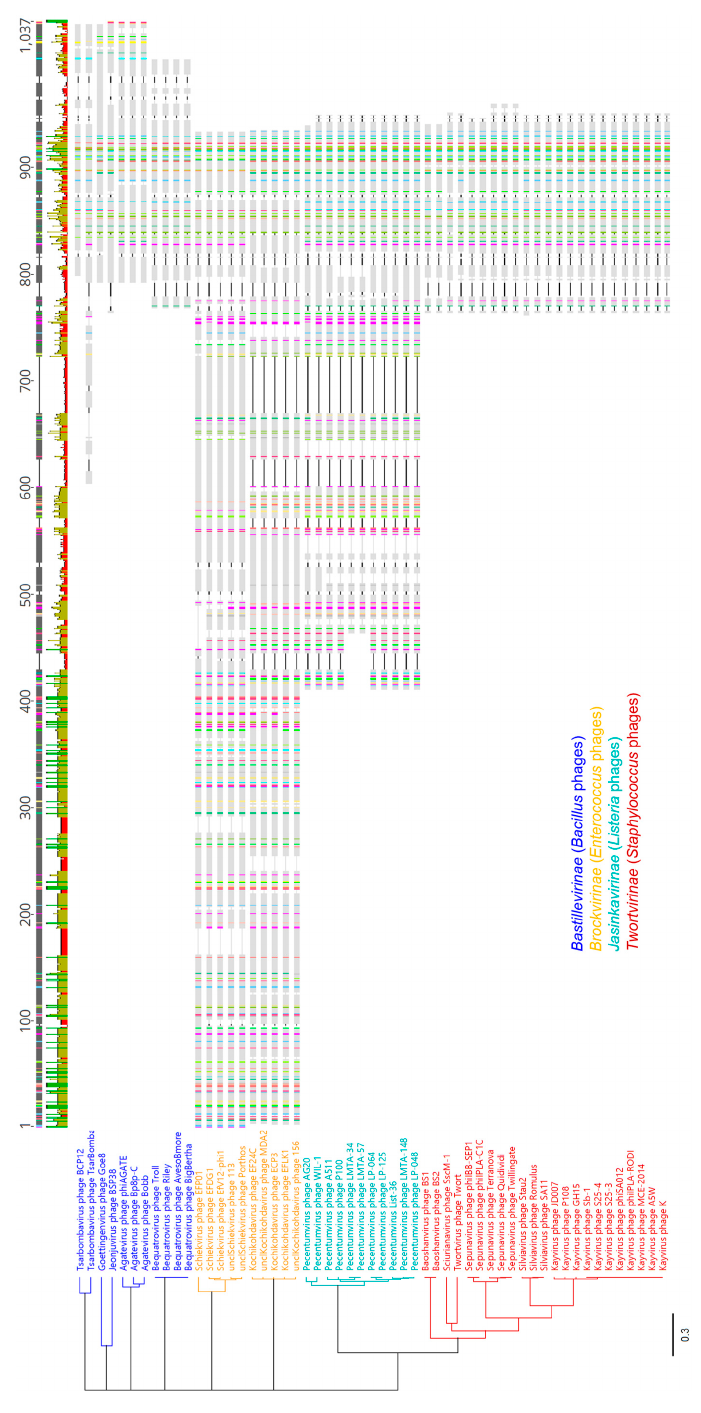
Figure 8. ClustalOmega alignment of predicted proteins with regions similar to Gp102, and a resulting UPGMA tree (Jukes–Cantor model, 100 bootstrap replicates). The alignment includes one representative of each ICTV-recognized species within each genus in which such proteins were